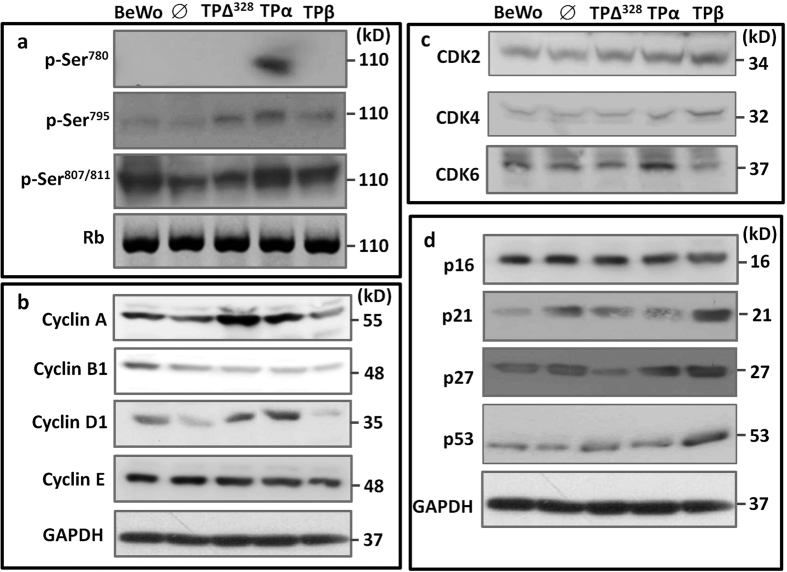
TP isoforms differentially regulate the molecular machinery controlling cell cycle progression.Immunoblotting of BeWo cells transfected with empty vector (∅), TPΔ328, TPα and TPβ was used to examine pRb phosphorylation (a), Cyclins (b), Cyclin-dependent kinases (CDK) (c) and tumour suppressor proteins (d). Non-phosphorylated Rb was used as the loading control in panel (a) and GAPDH was used as the loading control in panels (b-d). Blots are representative of 4 individual experiments. Densitometry was used to quantify changes in protein expression and activation status.